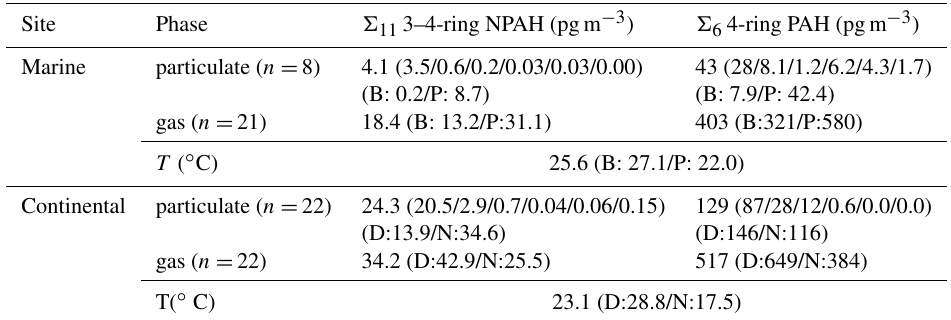
Figure 1. Time series of absolute ( a , c ; pgm − 3 ) and relative (b, d) total (gas + particulate) NPAH concentrations at the (a, b) marine (24h means shown) and (c, d) continental site (day–night means). At the marine site, the gas phase (PUF) was sampled for individual daytimes and nighttimes while the particulate phase (filter) was sampled over 24 or 48h (48h during the period of 7–12 July 2012). Table 1. Overview of time-weighted mean concentrations in the particulate and gas phases and ambient temperature. Data subsets (B is background, P is polluted, D is day mean, N is night mean) and mass size distribution (<0 . 45 / 0 . 45–0 . 95 / 0 . 95–1 . 5 / 1 . 5–3 . 0 / 3 . 0–7 . 2 / 7 . 2– 10µm aerodynamic equivalent diameter) in